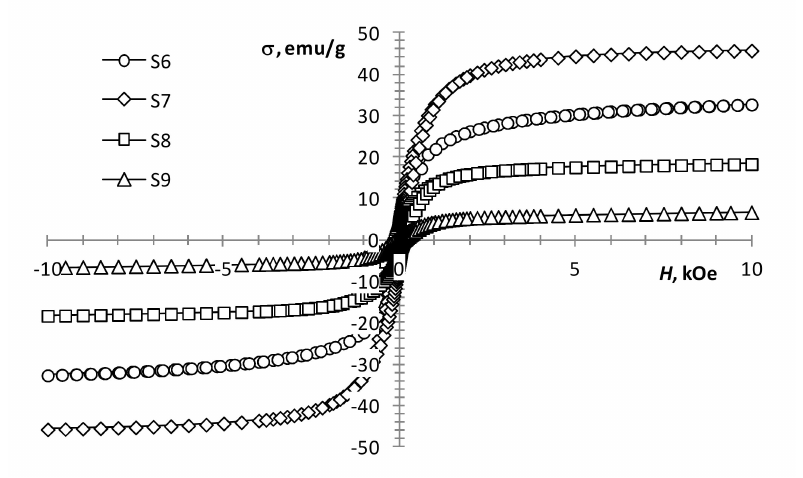
Figure 6. Magnetization loops of samples